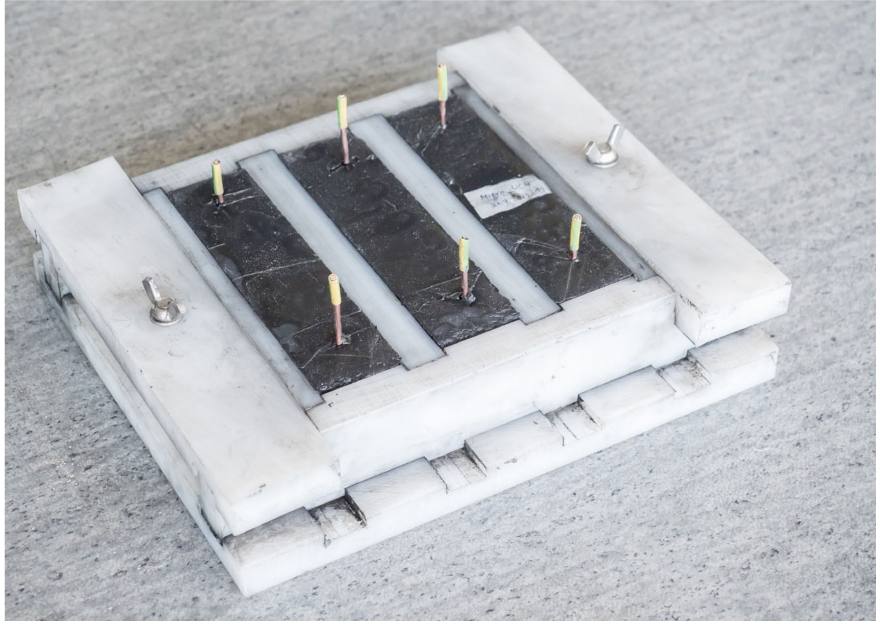
Figure 6. A mold with specimens set with electrodes for the measuring of